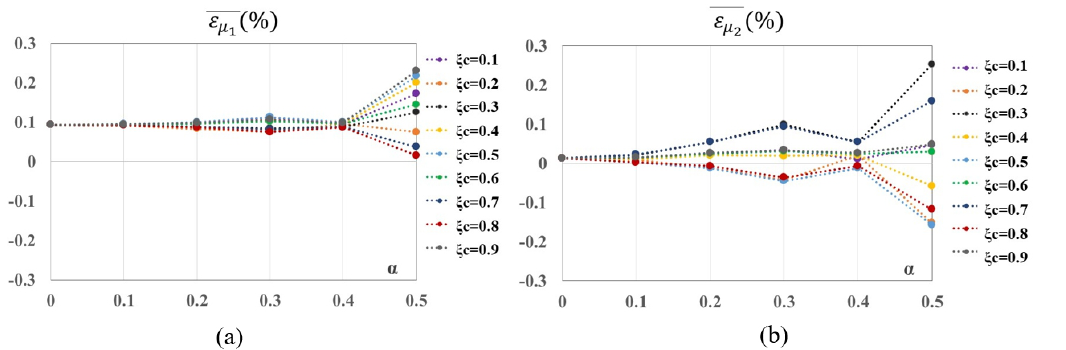
Figure 12. Mean percentage error considering each combination of α and ξ c for µ 1 ( a ) and µ 2 ( b ).